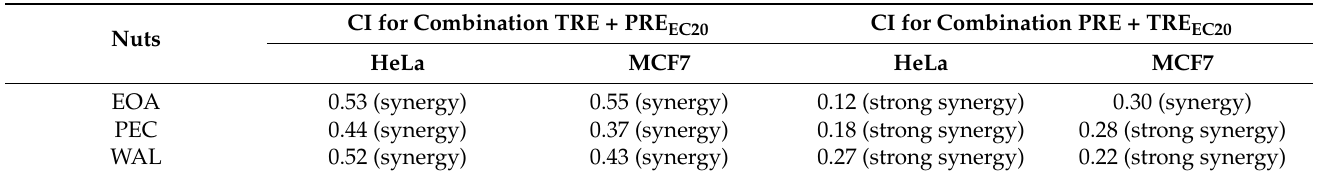
Table 5. Combination index (CI) to evaluate the interaction between TRE and PRE in cancer cell